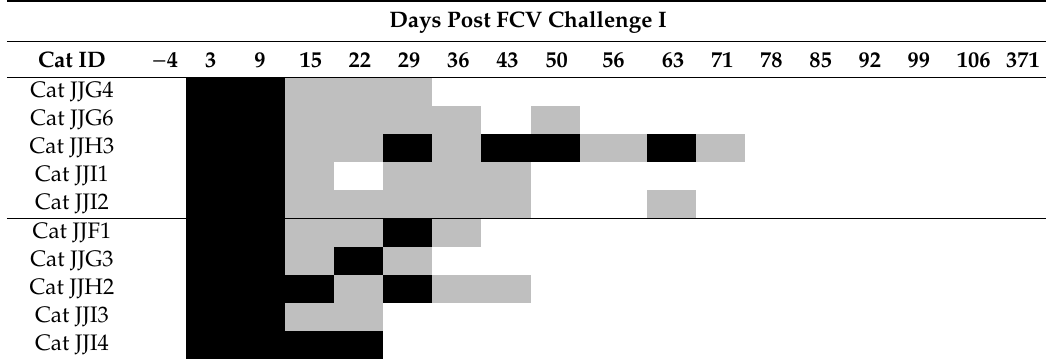
Table 1. Oropharyngeal shedding of FCV after the first experimental